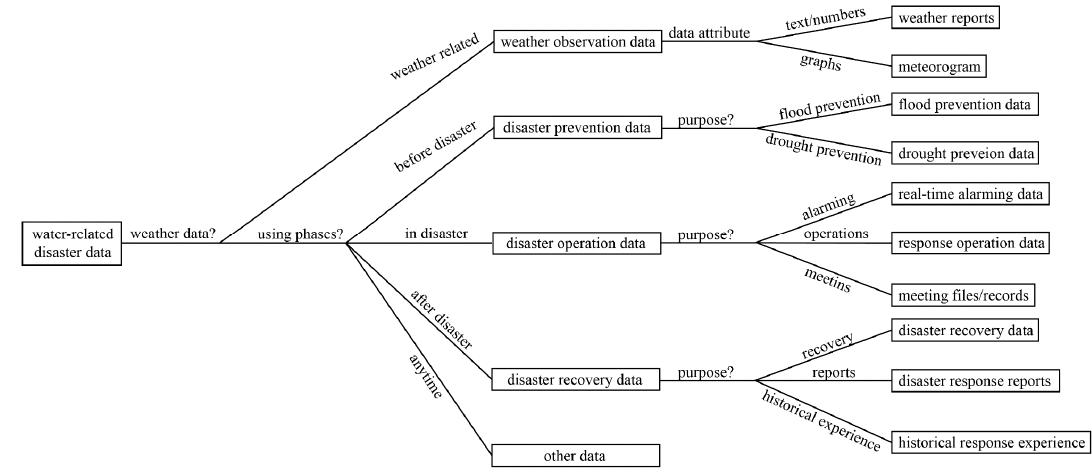
Figure 2. Decision tree model of Ask Diana.